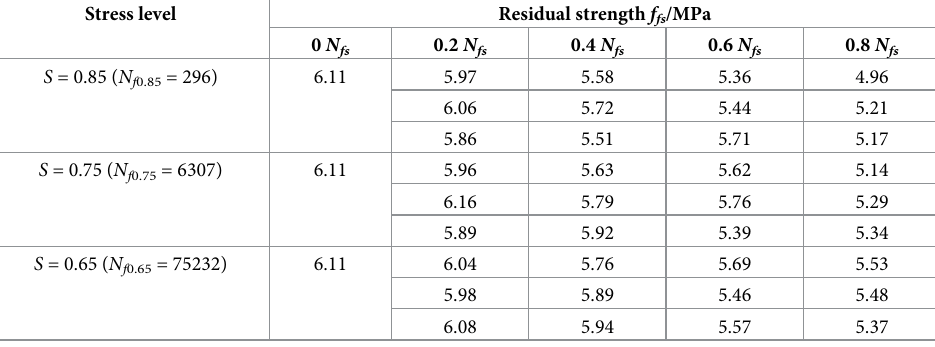
Table 9. Residual strength under single stage loading (failure probability P = 0.50, S = 0.85, 0.75,